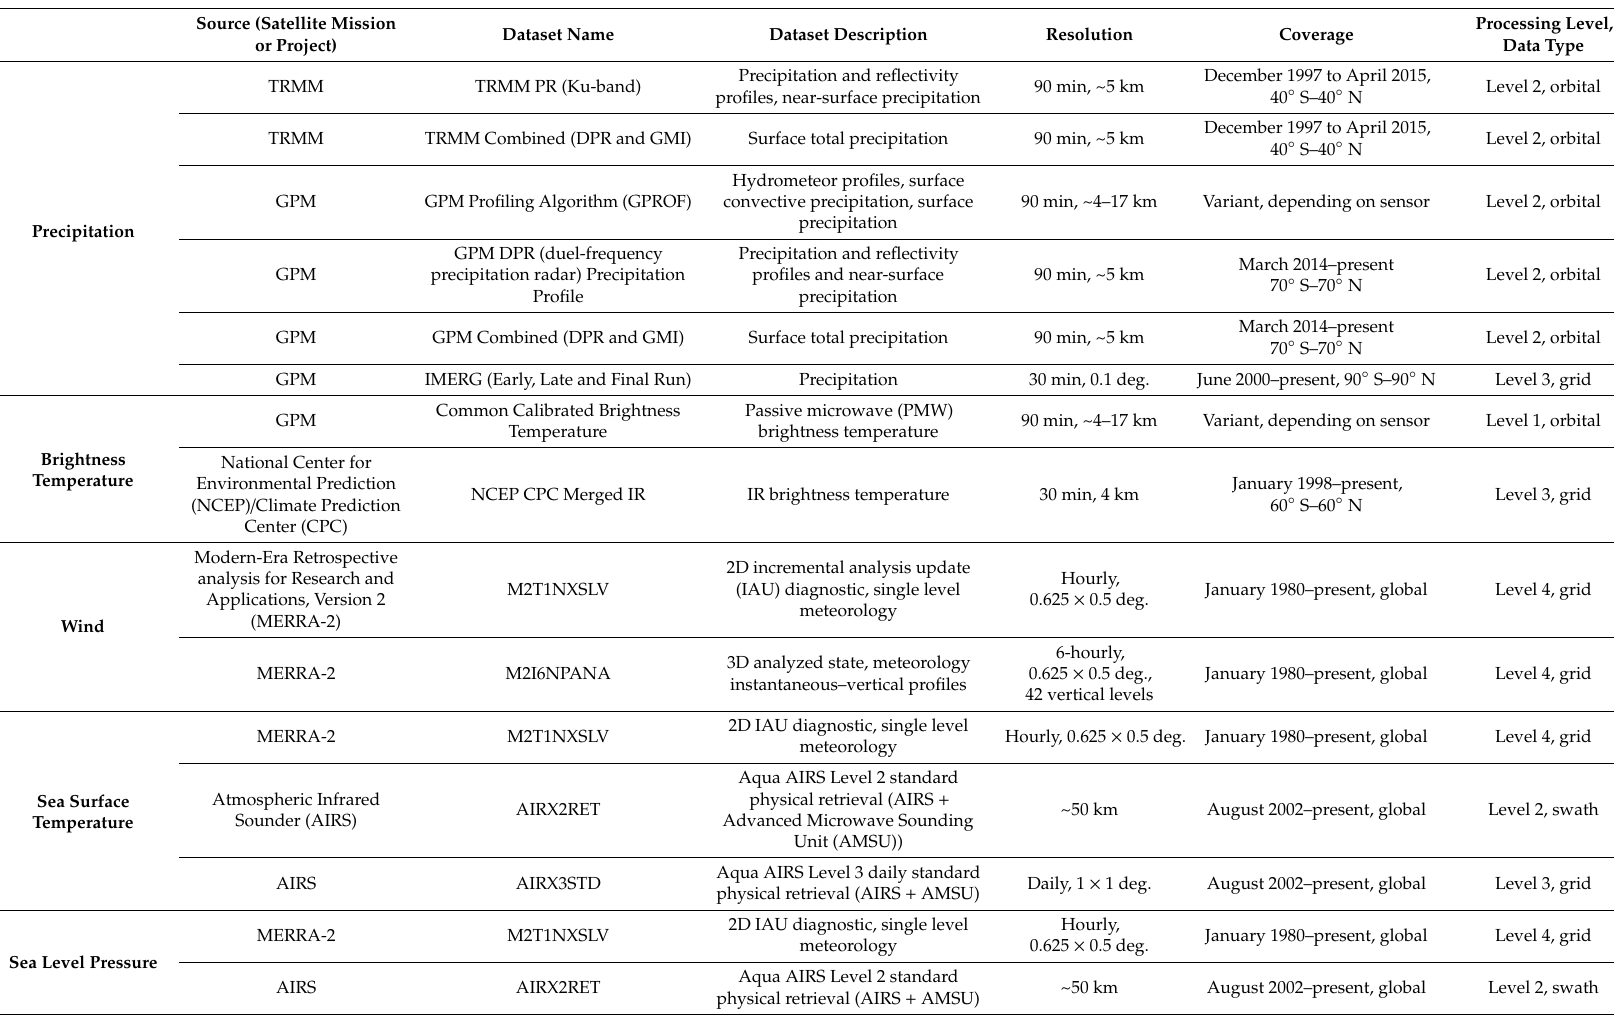
Table 3. NASA Goddard Earth Sciences Data and Information Services Center (GES DISC) satellite and model datasets recommended for tropical meteorology and